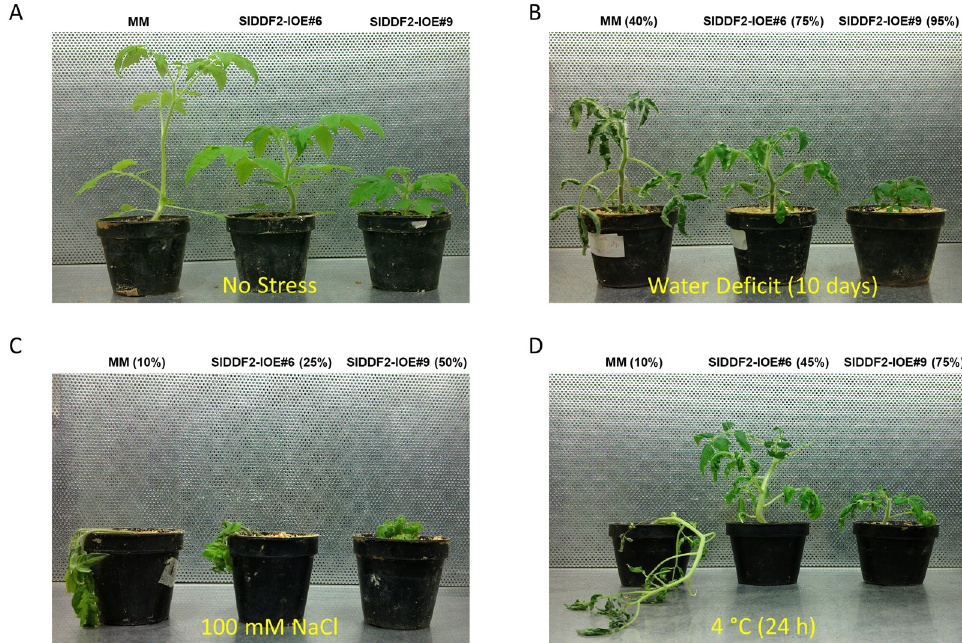
Figure 6. Representative MM and SIDDF2-IOE#6 and SIDDF2-IOE#9 transgenic lines grown under ( A ) normal conditions, ( B ) water deficit, ( C ) salinity, and ( D ) cold stresses (percentages are describing survival rate out of 20 plants per treatment).